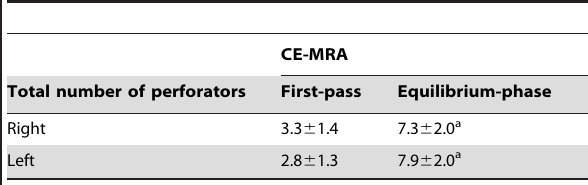
Table 3. Number of perforator branches as identified with